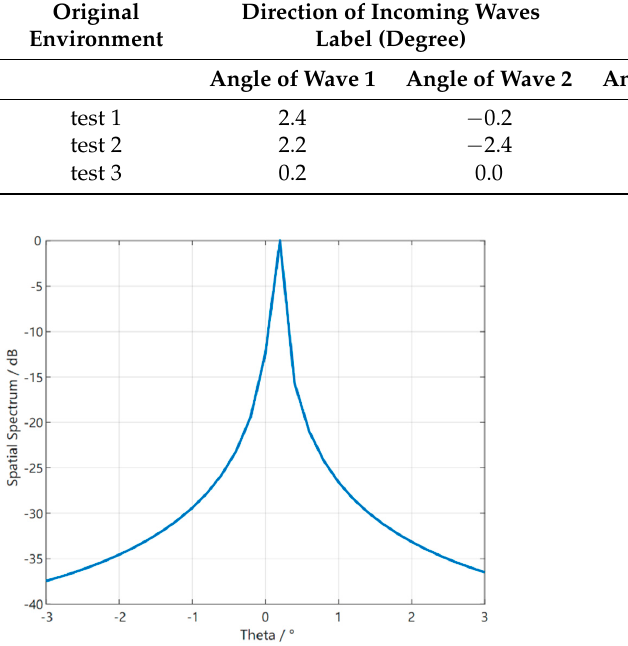
Figure 9. Error plots of the S2S network meta − reinforcement learning algorithm based on two perspec- tives in the original environment, respectively ( a , b ). ( a ) Error plot of the S2S network meta − reinforcement learning algorithm based on the first angle in the original environment. ( b ) Error plot of the S2S network meta − reinforcement learning algorithm based on the second angle in the original environment. Table 2. Identification results of coherent DOA in the original environment.